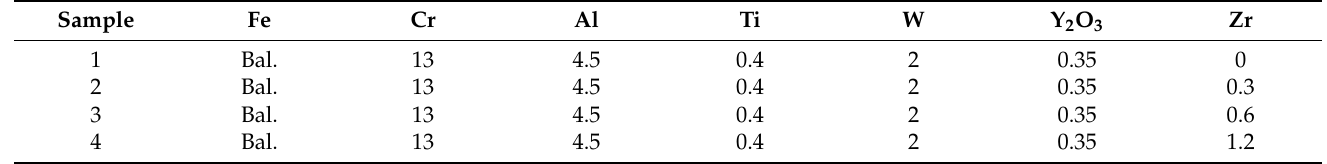
Table 1. Composition design of FeCrAl ODS steels containing Zr element (wt.%).